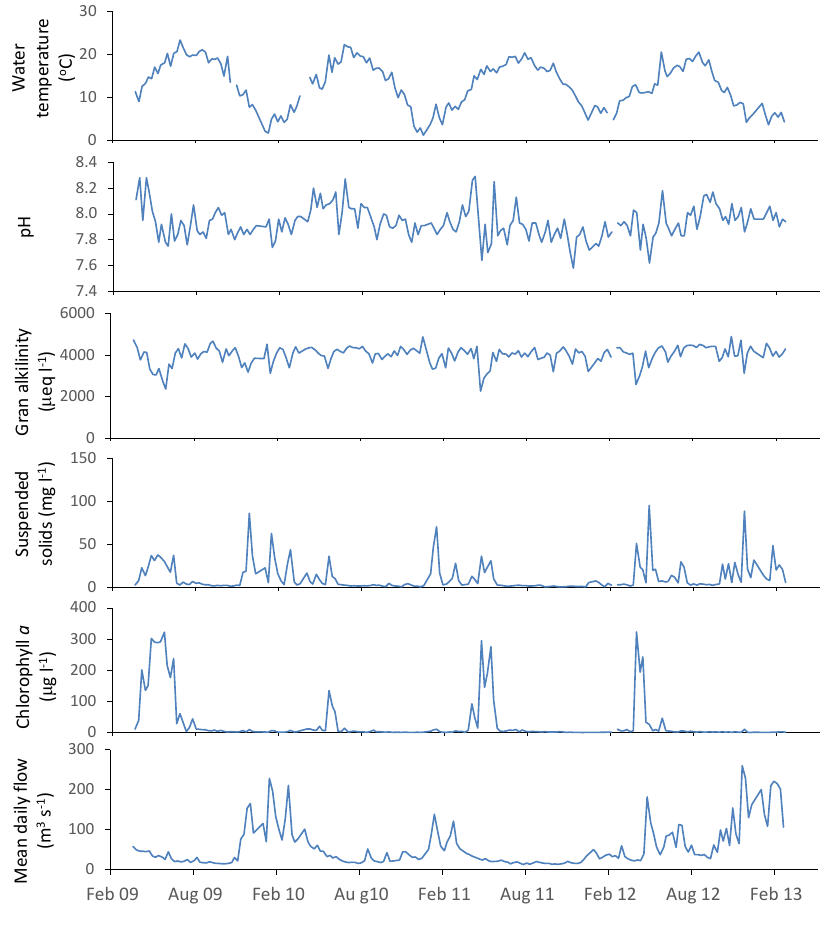
Figure 3. General water quality time series data for the downstream extent of the monitoring platform (River Thames at